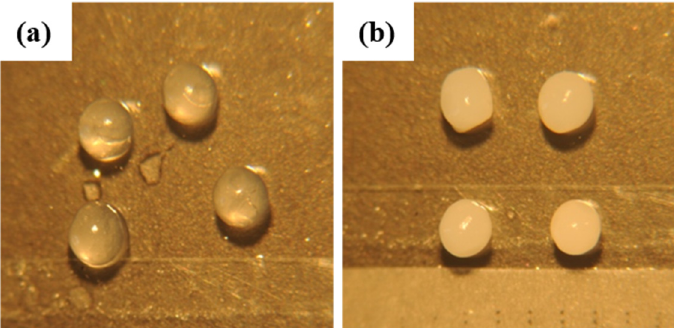
Figure 4. Photograph of CA ( a ) and hybrid CA-MTN ( b ) microcapsules. Magnification ×10 . Table 3. Size and morphology parameters of CA and hybrid CA-MTN microcapsules.